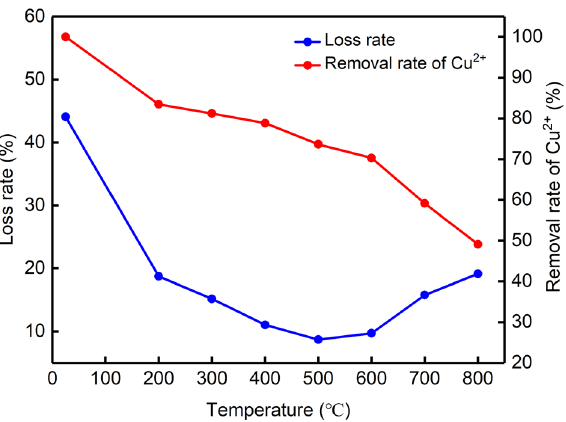
Figure 7. Effect of different calcination temperatures on the loss rate and Cu 2+ removal rate of 3:7 particles.